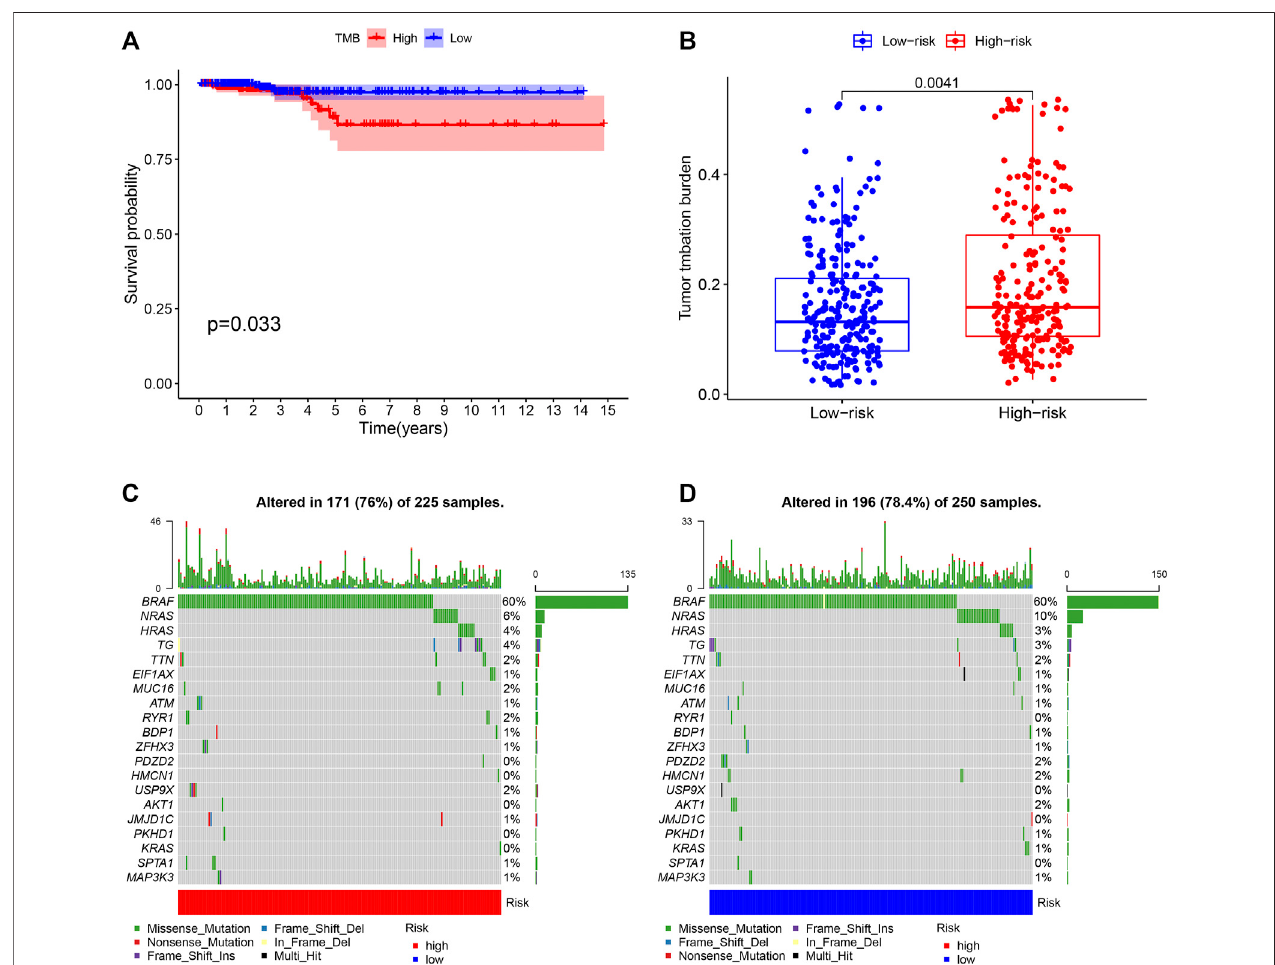
FIGURE 8 | Association of TMB with OS and RS (A) Survival analysis of THCA patients with high- and low-TMB (B) Comparisons of TMB in low- and high-RS groups (C) (D) Waterfallplot formutation pro fi les ofthetop20genesinTHCA samplesofhigh-and low-RS groups, respectively. Annotations withdifferentcolorsat the bottomreferredtothevariousmutationtypesandbarchartabovepresentedmutationburden.Therightshowednameofmutatedgenesandtherightdisplayedpercent of gene mutation. TMB, tumor mutation burden; OS, overall survival; RS, risk score.